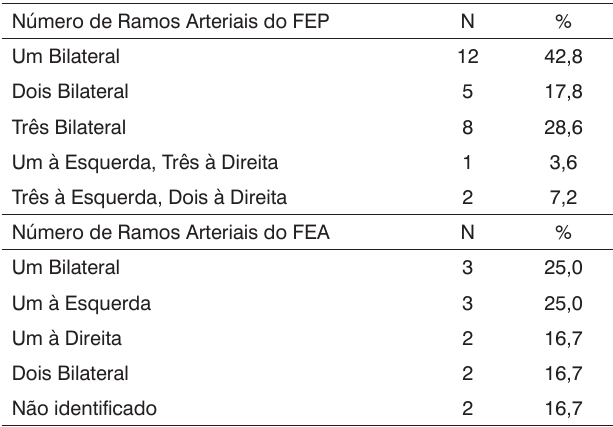
Tabela 4. Distribuição em valores absolutos e percentuais do número de troncos arteriais nos Forames Esfenopalatinos Principais (FEP) e Acessórios